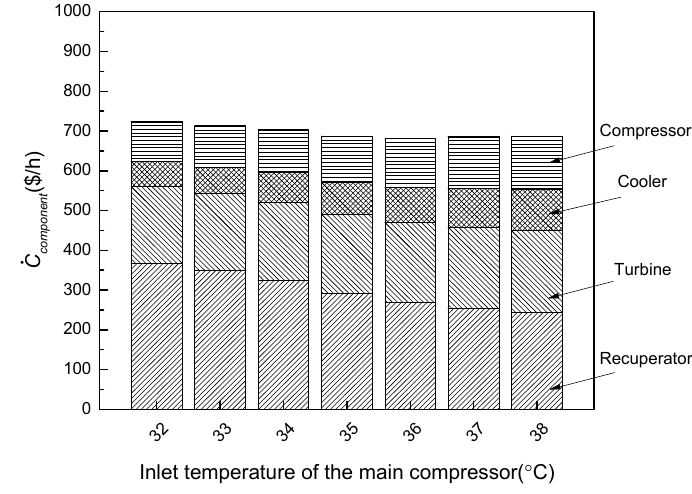
. C component with the partial-cooling cycle. Figure 15. Effects of T min on Figure 15. Effects of 𝑇 (cid:3040)(cid:3036)(cid:3041) on 𝐶(cid:4662) (cid:3030)(cid:3042)(cid:3040)(cid:3043)(cid:3042)(cid:3041)(cid:3032)(cid:3041)(cid:3047) with the partial-cooling cycle.